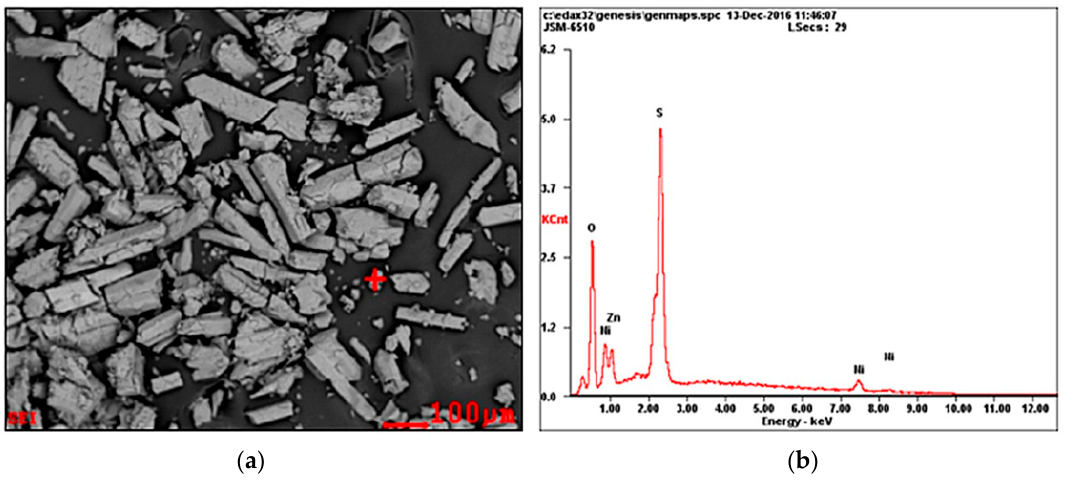
Figure 9. SEM and EDS diagrams of NiSO 4 crystal products. ( a ) SEM; ( b ) EDS.